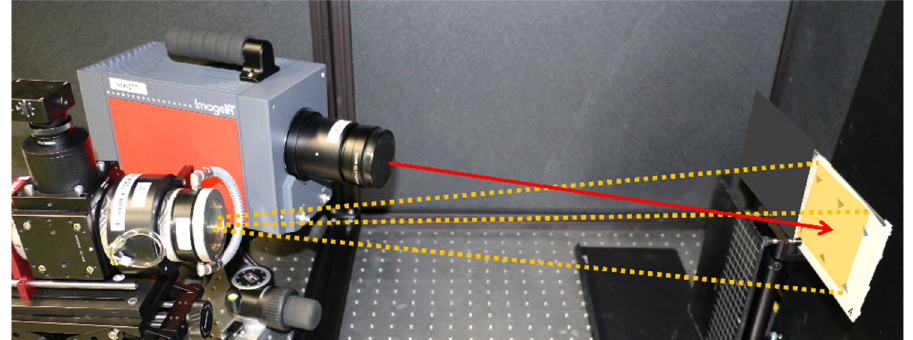
Figure 2. Experimental setup under lab conditions. The orange dotted lines indicate the beam shape of the laser optics on the left side; the infrared camera is located behind. With the related optical axis, the inspected object can be seen on the right margin, where the orange rectangle indicates the heated region (13 × 13 cm 2 area) of the object.